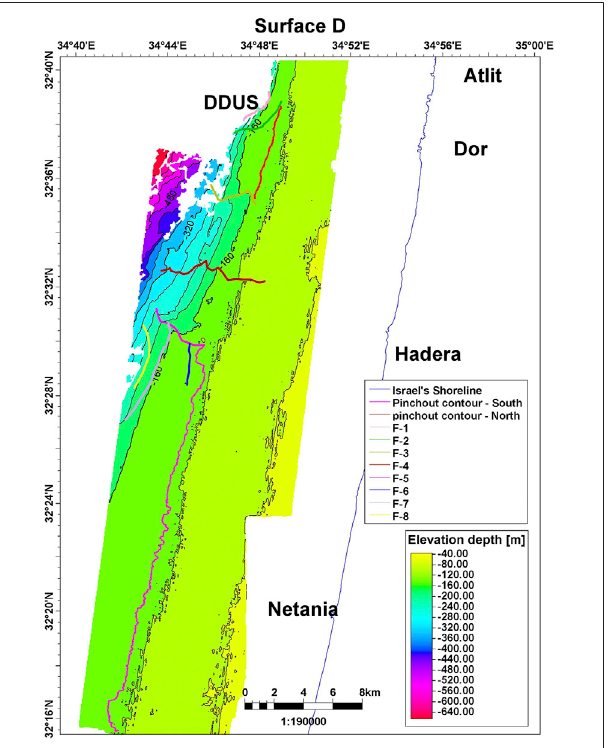
FIGURE 8 | Seismic mapping of Horizon